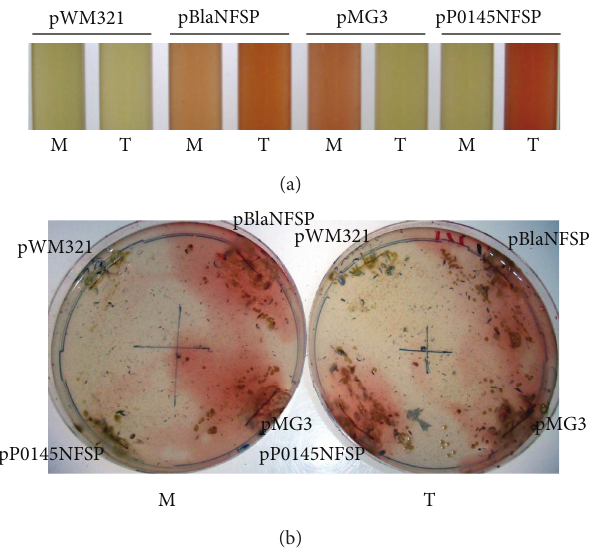
Figure2:Growthsubstrate-dependentnitrocefincleavage.Cultures of M. acetivorans transformed with pWM321 (negative control), - fsp - blaN ), pMG3 ( mtaC1 - pBlaNFSP (positive control, mcrB p P - fsp - blaN ) were grown on fsp - blaN ), and pP0145NFSP ( mtmC1 P methanol (M) or trimethylamine (T) and assayed for Bla (see Materials and Methods) in liquid culture (a) or after streaking and growth on agar plates containing the respective substrate (b); shown are sections of the culture tubes (a) and plates (b) after 20 min of incubation at room temperature in the presence of